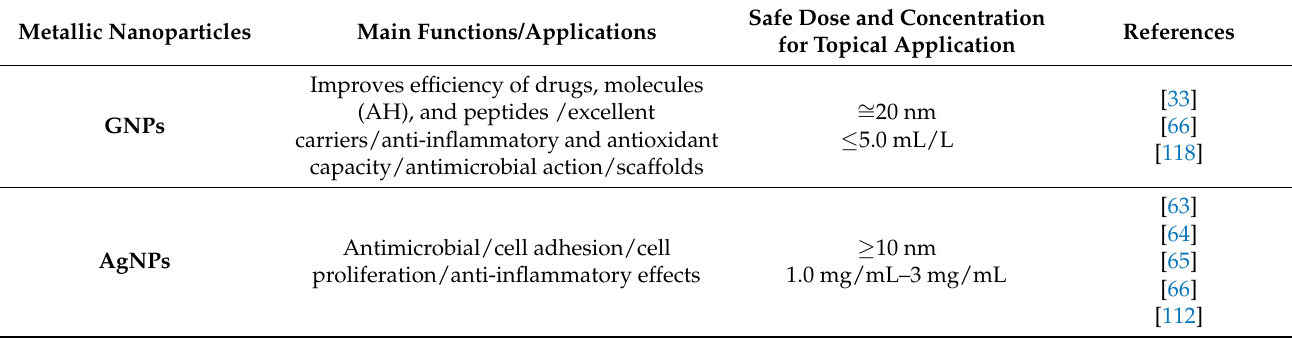
Table 1. Main functions and applications of metallic nanoparticles used for wound healing. Metallic Nanoparticles Main Functions/Applications Improves efficiency of drugs, molecules (AH), and peptides /excellent GNPs carriers/anti-inflammatory and